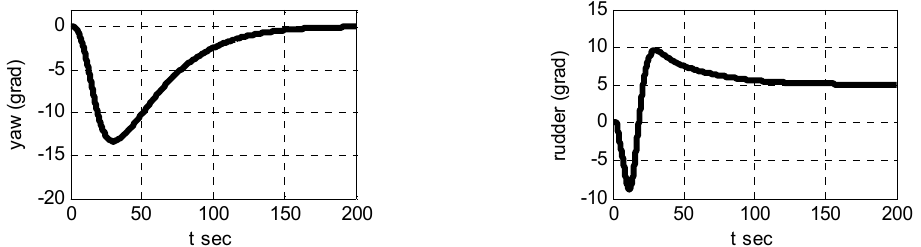
Figure 7. Graphs of the functions y ( t ) and δ ( t ) for the reference closed-loop connection in Regime 2 Figure 7. Graphs of the functions )( ty and )( t δ for the reference closed-loop connection of in Regime 2 of motion. Figure 7. Graphs of the functions )( ty and )( t δ for the reference closed-loop connection in Regime 2 of motion. Figure 7. Graphs of the functions )( ty and )( t δ for the reference closed-loop connection in Regime 2 of motion.